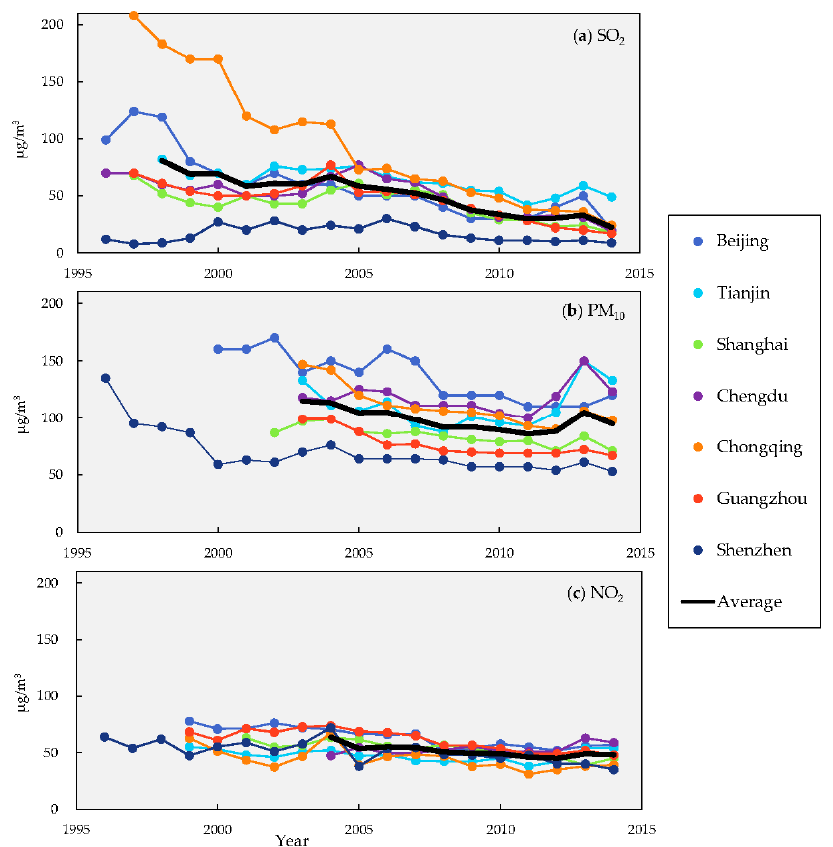
Figure 2. Trends of SO 2 ( a ); PM 10 ( b ) and NO 2 ( c ) annual concentrations of seven China megacities in 1996–2014 [26–32].